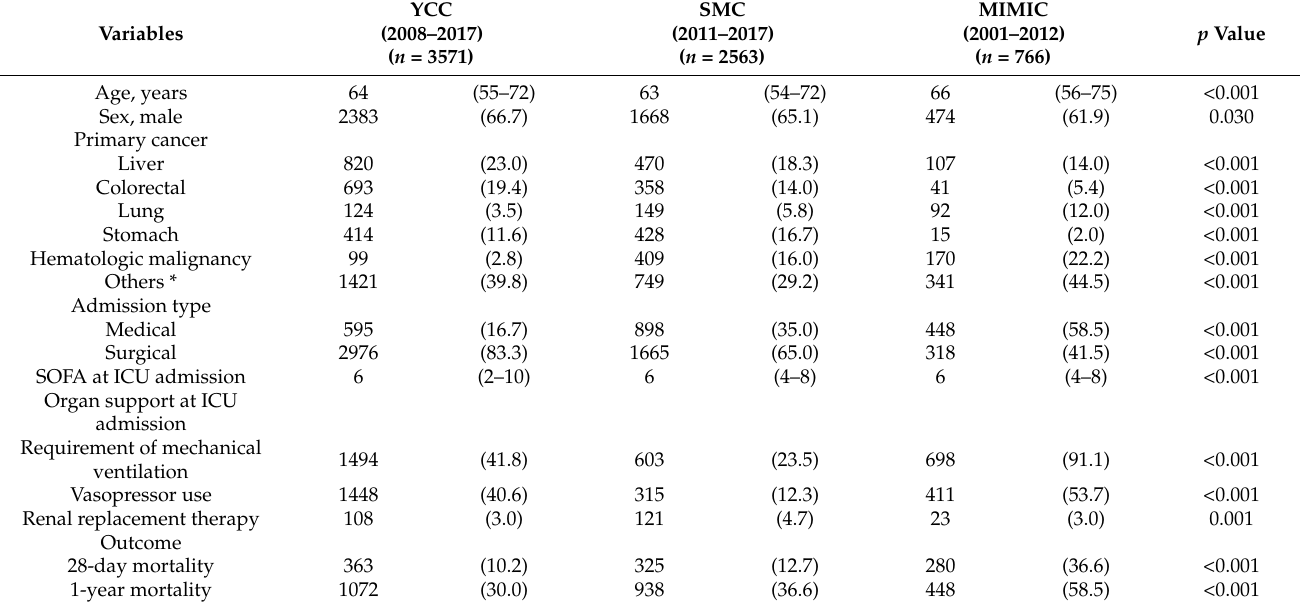
Table 1. Baseline characteristics and outcomes.